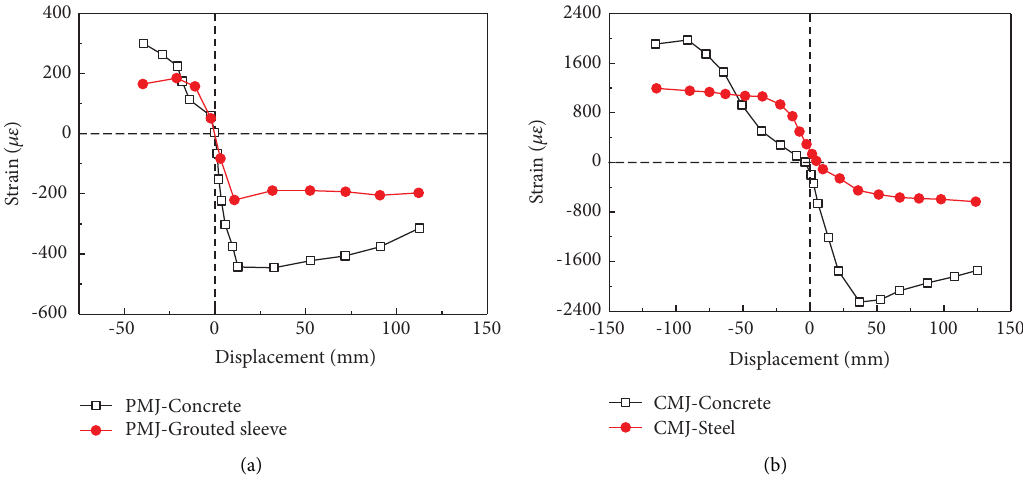
Figure 8: Representative comparisons of strain between concrete and steel: (a) specimen PMJ and (b) specimen CMJ.